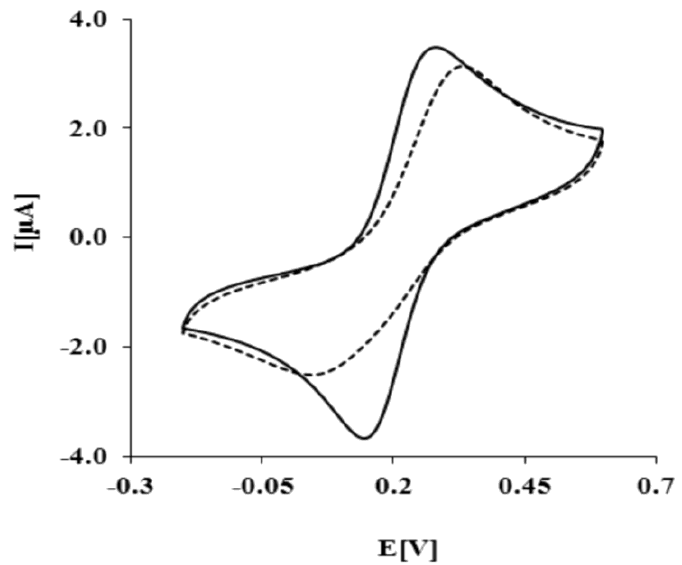
Figure 2. The CV curves measured for gold electrode: bare (solid line), or modified with NAC/DPTA–Cu(II) SAM (dashed line). Solution composition: 0.1 M KCl + 1 mM [Fe(CN) ] 3−/−4 . Measuring conditions: reference electrode Ag/AgCl, counter electrode Pt; 6 scan rate 100 mVs −1